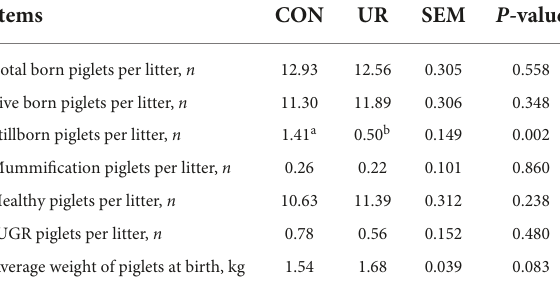
TABLE 2 Effect of UR on reproductive performance of